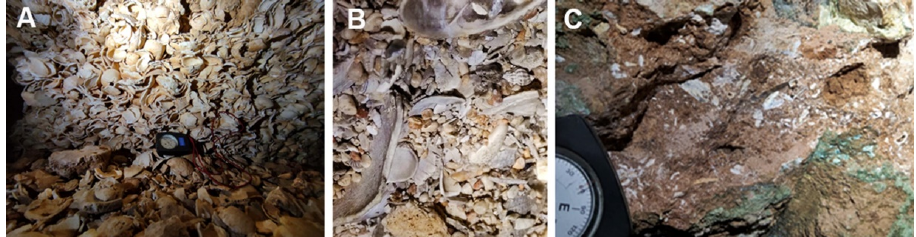
Figure 19. ( A ) Fossiliferous deposit made by Glycymeris shells. ( B ) detail showing bivalve shells and other mollusc remains (rissoid gastropods). ( C ) Bone-bearing red breccia. Bivalve shells are abraded and frequently broken, cemented by calcite concretions;